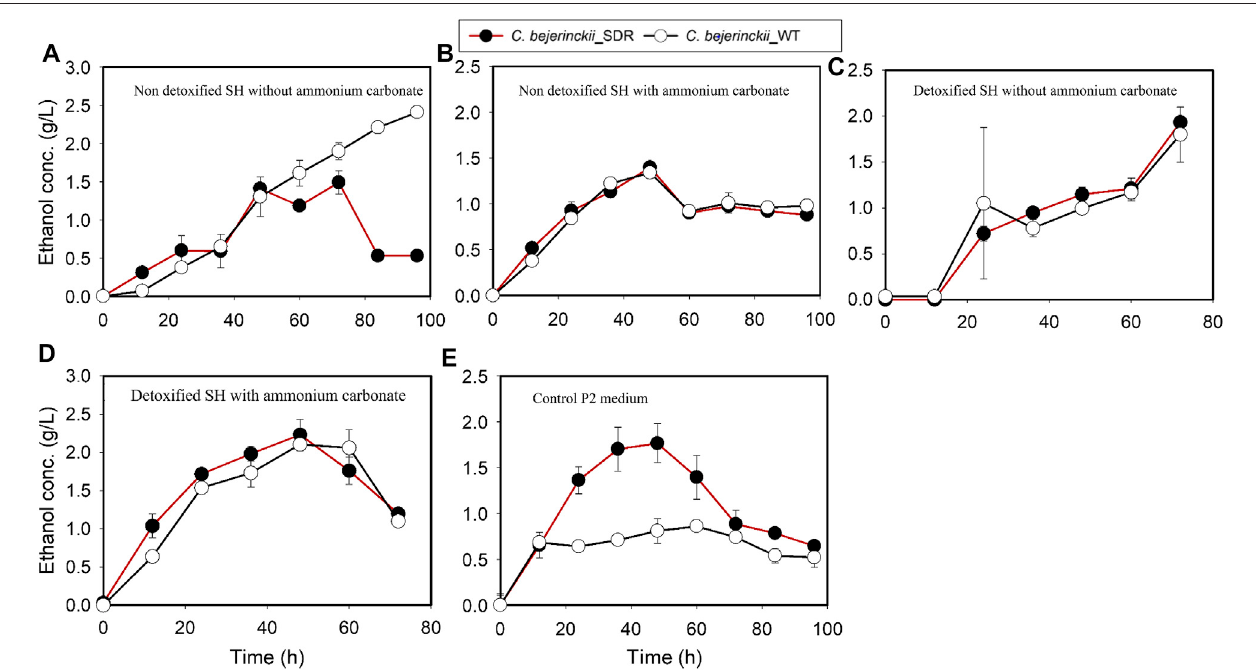
FIGURE 6 | Ethanol concentration pro fi les in cultures of C. beijerinckii _SDR or C. beijerinckii _wildtype grown in SH and P2 medium control. (A) Non-detoxi fi ed SH without ammonium carbonate. (B) Non-detoxi fi ed SH with ammonium carbonate. (C) Detoxi fi ed SH without ammonium carbonate. (D) Detoxi fi ed SH with ammonium carbonate. (E) Control P2 medium.